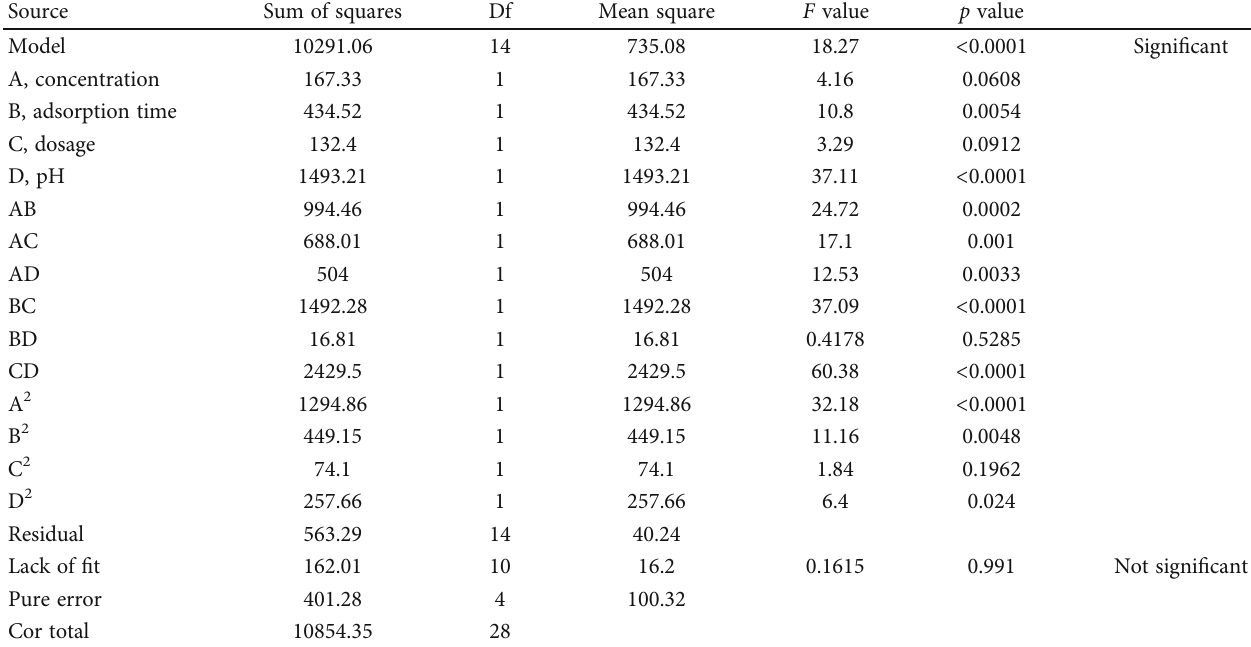
Table 2: ANOVA results.